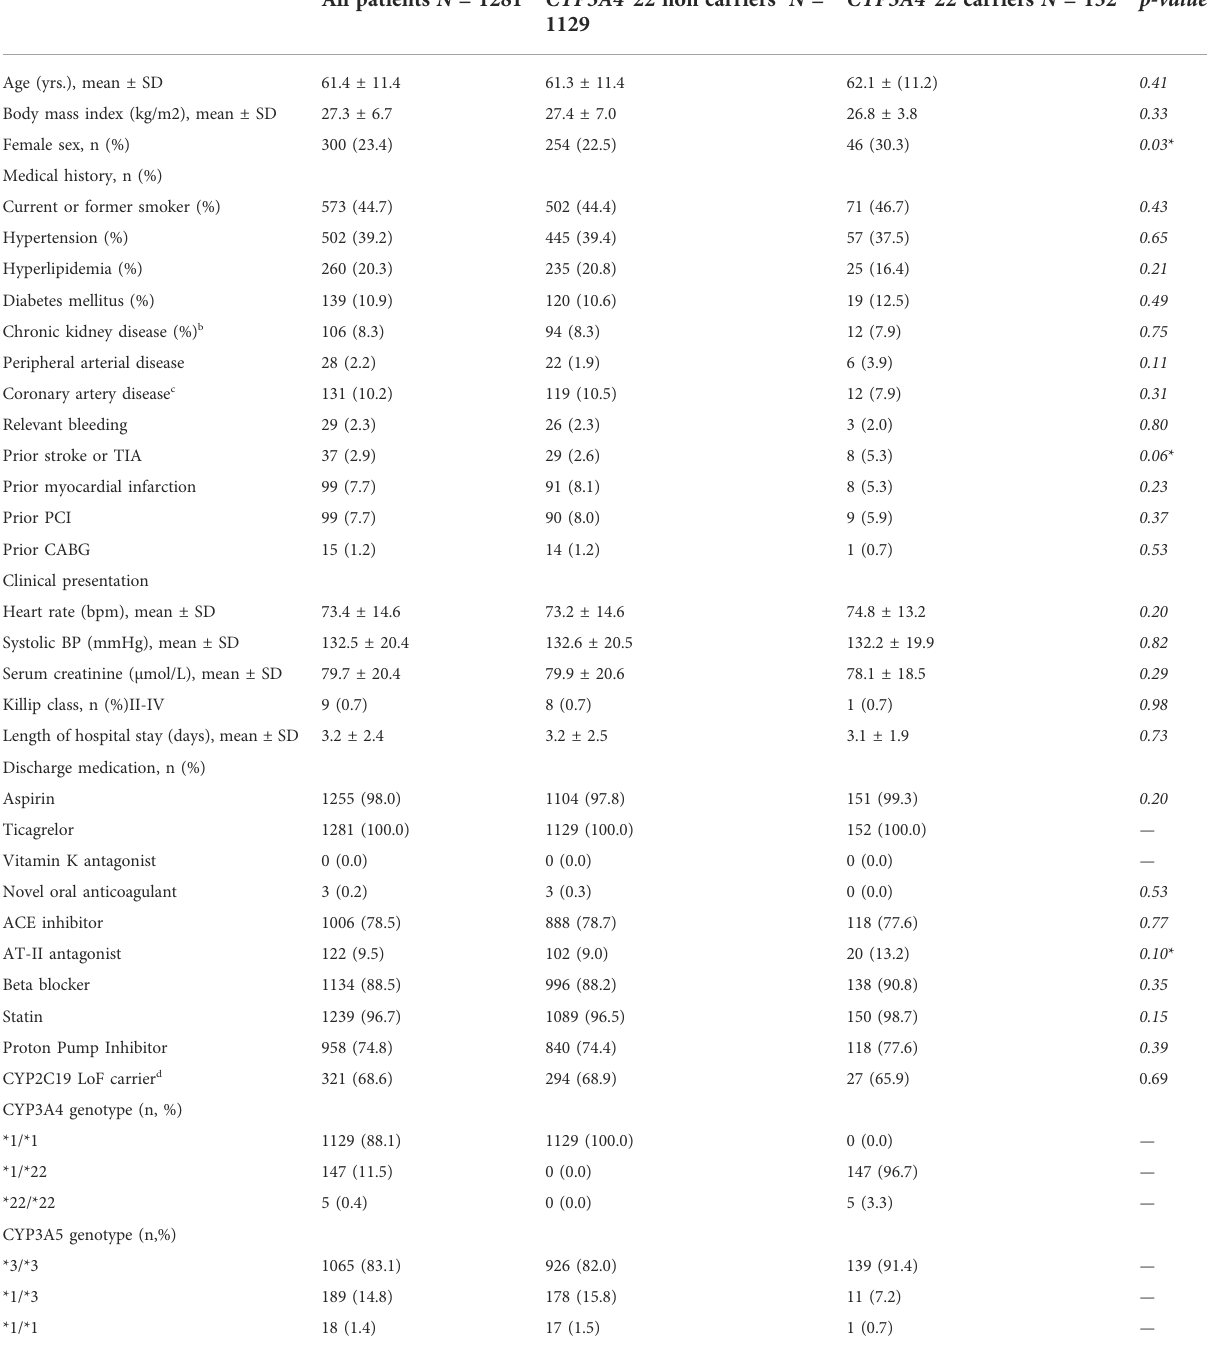
TABLE 1 Baseline characteristics of ticagrelor treated patients according to CYP3A4